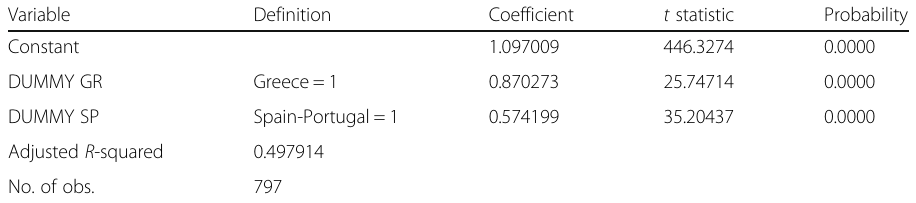
Table 1 WPR vs dummies for Greece and the Spain-Portugal group (SP) Variable Definition Coefficient t statistic Probability Constant 1.097009 DUMMY GR Greece = 1 0.870273 DUMMY SP Spain-Portugal = 1 0.574199 0.0000 Adjusted R -squared 0.497914 No. of obs.